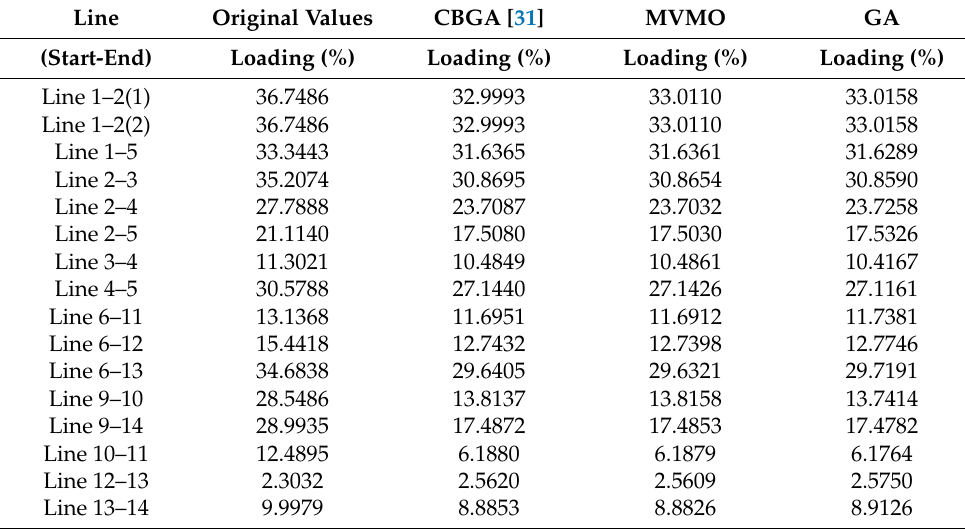
Table 11. Loading conditions of lines for the IEEE 14-bus test